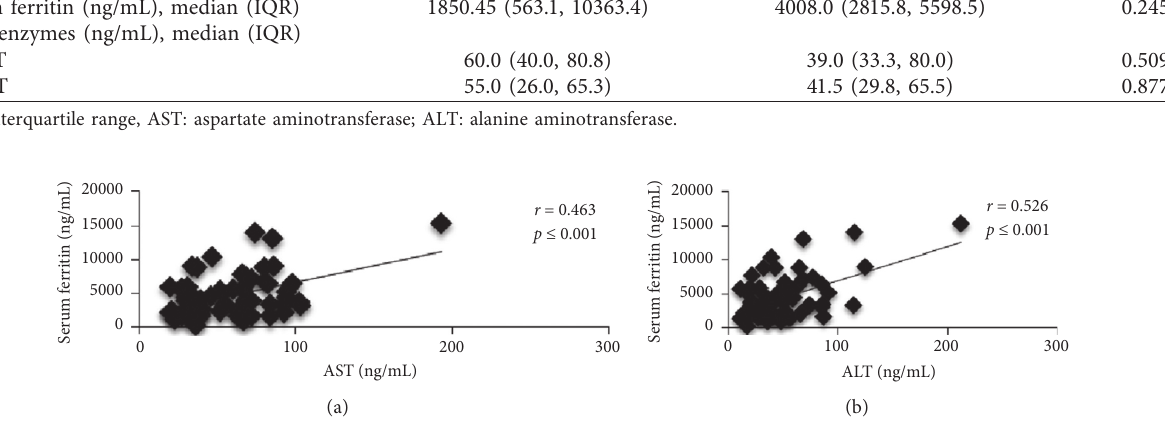
Figure 1: Correlation between serum ferritin and liver enzyme. (a) Correlation between serum ferritin and aspartate aminotransferase (AST). (b) Correlation between serum ferritin and alanine aminotransferase (ALT).